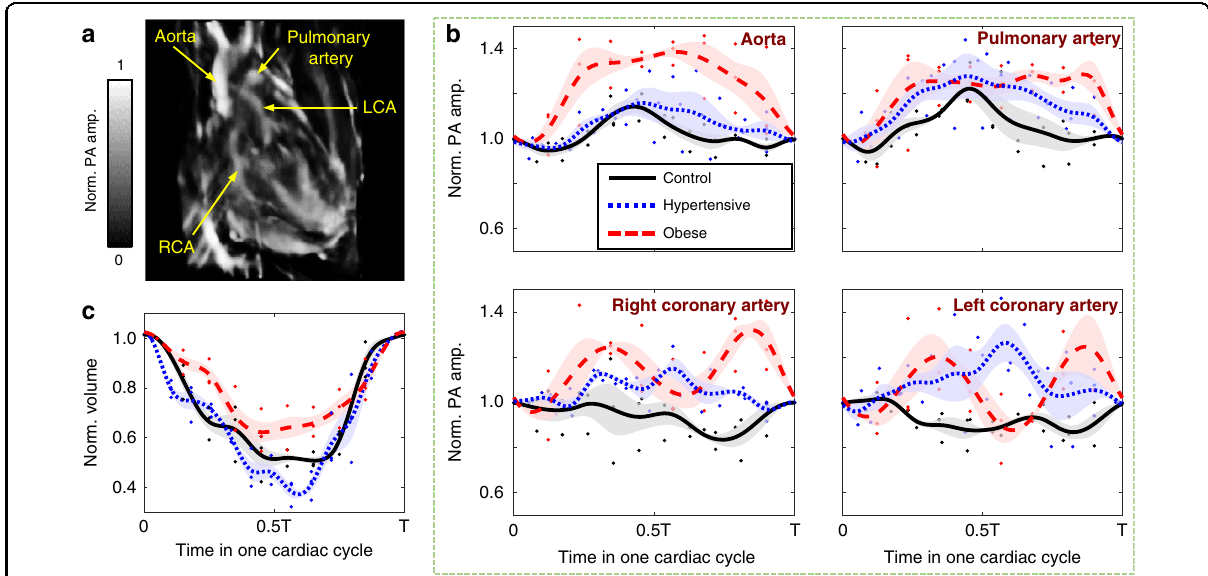
Fig. 4 Cardiac hemodynamics in control (i.e., healthy), hypertensive, and obese hearts. a A heart image acquired by the 3D-PACT shows the aorta, pulmonary artery, right coronary artery (RCA), and left coronary artery (LCA). b PA signal fl uctuations in the four cardiac vasculatures among the control, hypertensive, and obese hearts ( n = 3 for each group). c Relative changes in ventricular volume of the control (black solid line), hypertensive (blue dashed line), and hypertrophic (red dashed line) hearts during a cardiac cycle ( n = 3 for each